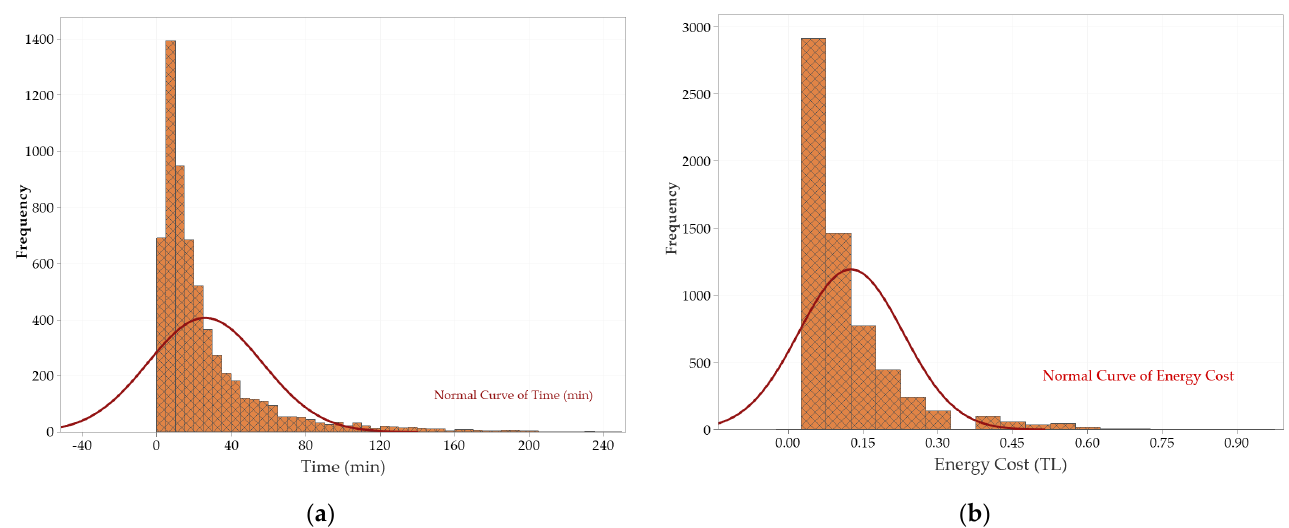
Figure 2. The data sets of the output variables: ( a ) the delivery time; ( b ) energy cost.